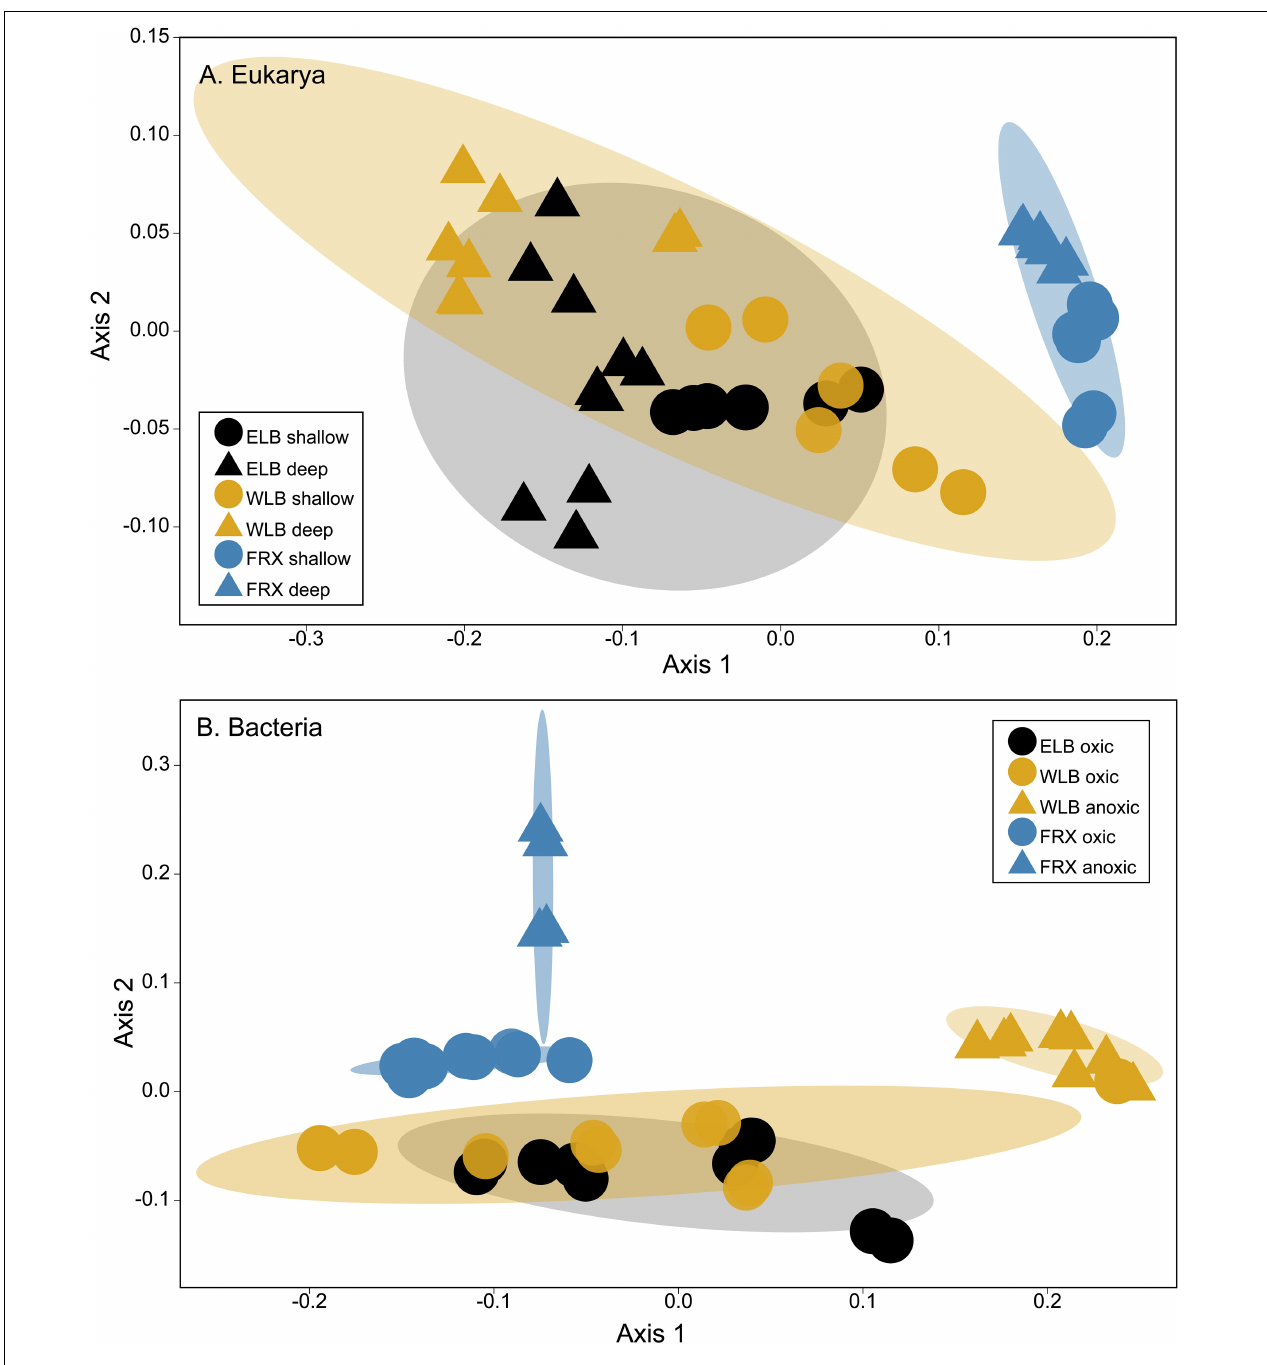
FIGURE 4 | (A) A non-metric multidimensional scaling (NMDS) plot of eukaryotic communities (OTU counts, Bray-Curtis dissimilarity, stress = 0.077). Shaded areas indicate 90% similarity within each lake. Shallow: epilimnion. Deep: chemocline + hypolimnion. (B) A NMDS plot of bacterial communities (OTU counts, Bray-Curtis dissimilarity, stress = 0.072). Oxic and anoxic: upper oxic zone and deep anoxic zone in the water columns, respectively. Shaded areas indicate 75% similarity within each lake.